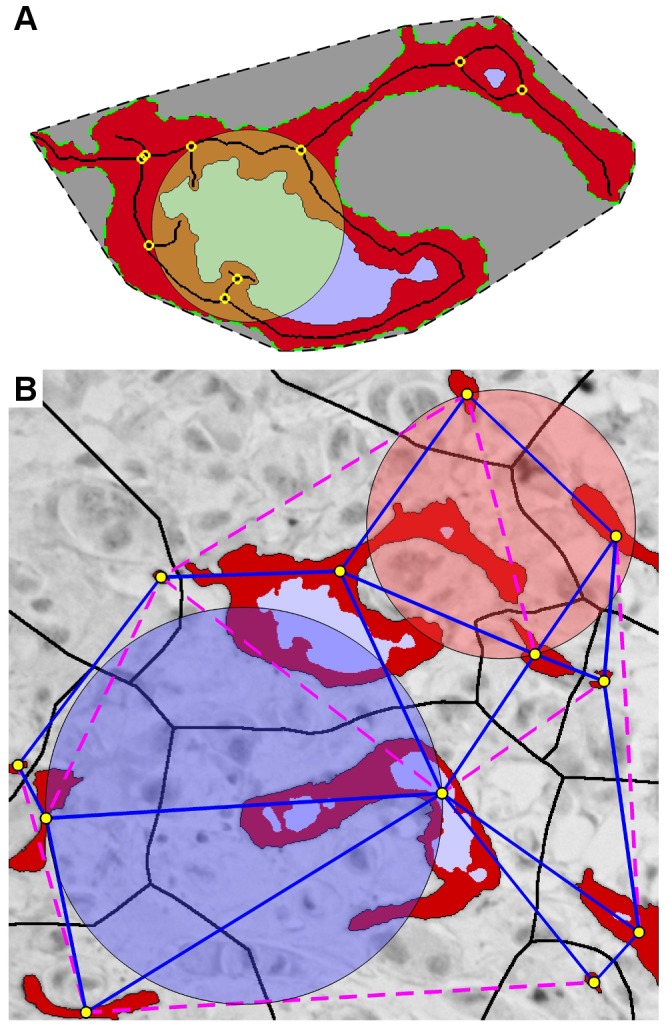
Illustration of the quantified vascular features.A) Individual vessel characterization: Endothelial area (red); luminal area (blue); vessel/vascular area (red + blue); vessel perimeter (stapled green); width (diameter of imposed yellow circle); skeleton (black line); branching points (yellow markers); convex hull (interior of stapled black line, i.e. vessel + gray). B) Contextual vasculature characterization: centre of vessel (yellow markers); Neighbouring vessels according to the Gabriel's Graph criterion (blue lines), i.e. all connections between vessels such that no other vessel centres are found within the circle spanned by the connecting line (see blue circle). Vertices which do not fit the criteria are not considered neighbours (magenta stapled lines; see red circle); equidistant watershed lines (black), each region within the black lines is closer to the enclosed vessel than any other vessel.